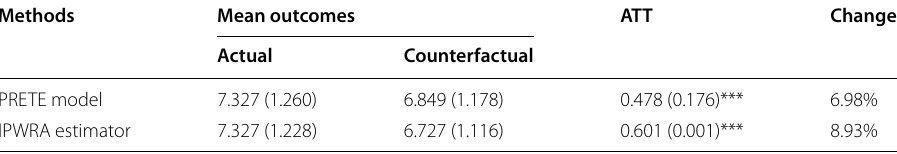
*** p < 0.01. Robust standard errors are presented in parentheses ATT: Aaverage treatment effects on the treated, ETPR: Poisson regression with endogenous treatment effects, IPWRA: Inverse-probability-weighted regression adjustment